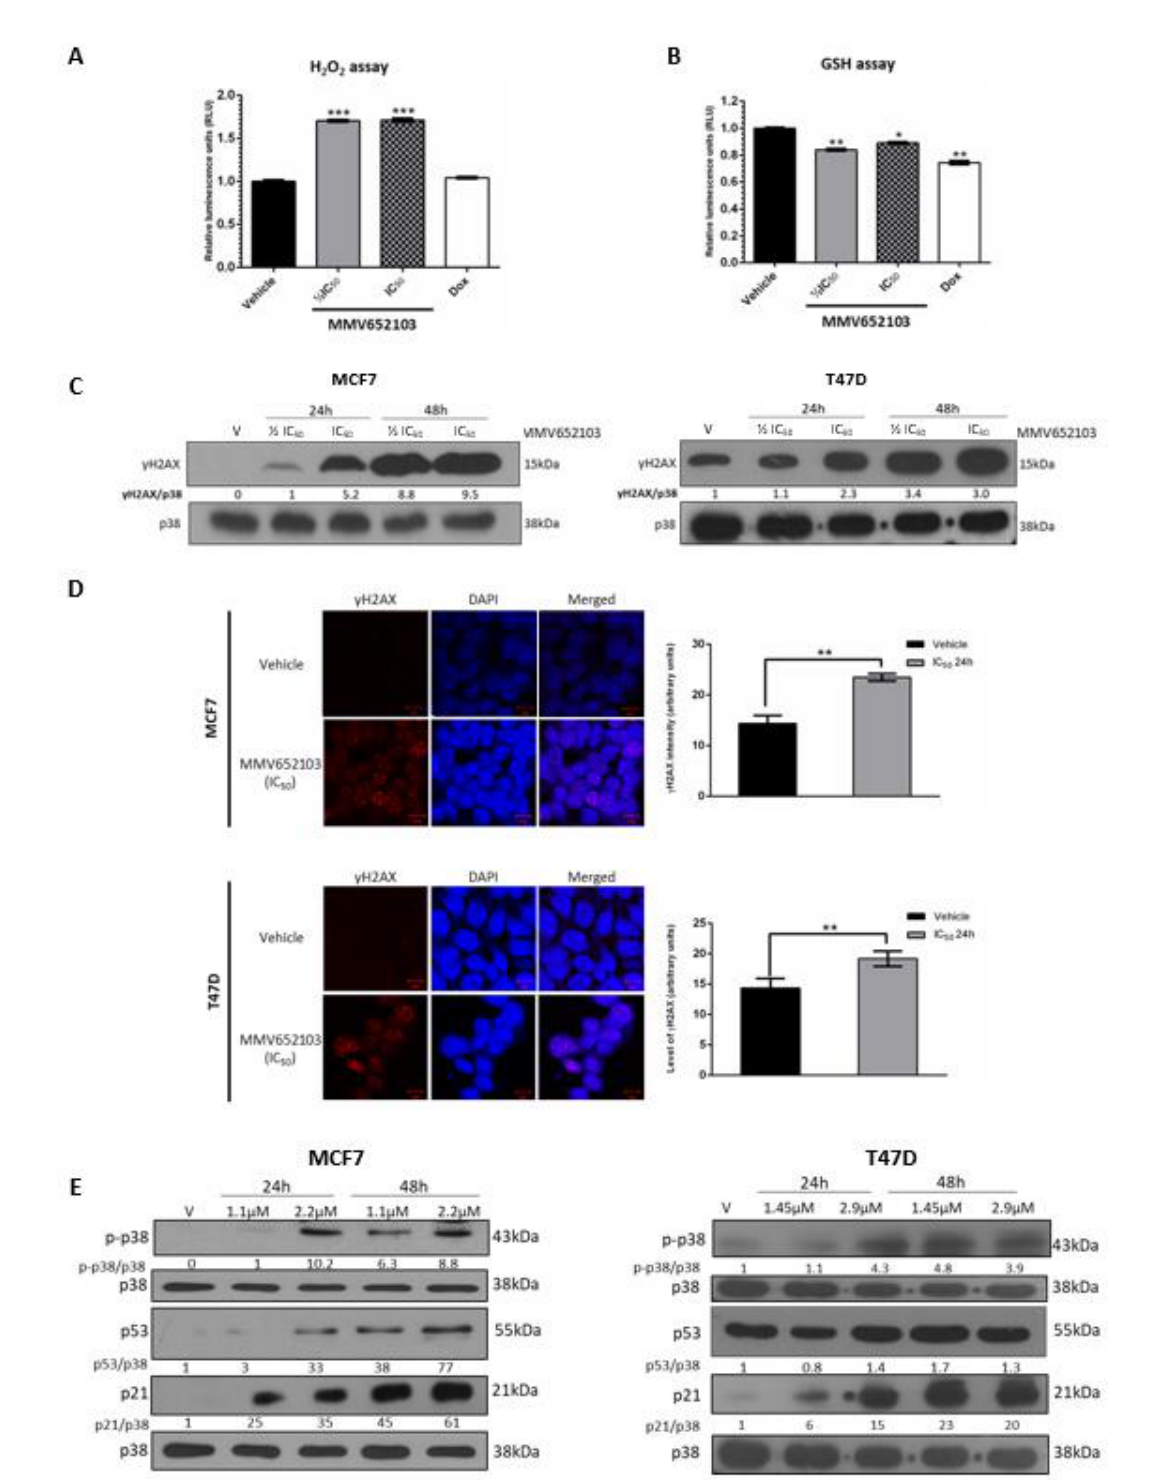
Figure 4: MMV652103 induces the production of reactive oxygen species (ROS) and induces double-strand DNA breaks. Levels of cellular ( A ) H 2 O 2 and ( B ) GSH in MCF7 cells after 24 h treatment with ½ IC 50 and IC 50 concentrations of MMV652103. Doxorubicin at its IC 50 concentration (9.84 nM) for MCF7 cells was used as a control. Graphs show the mean H 2 O 2 and GSH levels of three independent experiments ± SEM. ( C ) MCF7 and T47D cells were treated with vehicle (DMSO), ½ IC 50 and IC 50 for 24 and 48 h and western blotting performed to determine the levels of γH2AX. ( D ) Immunocytochemistry of MCF7 and T47D cells treated with vehicle (DMSO) and IC 50 for 24h. Images were captured under a confocal microscope (Zeiss, Germany) at 600X magnification and are representative of five